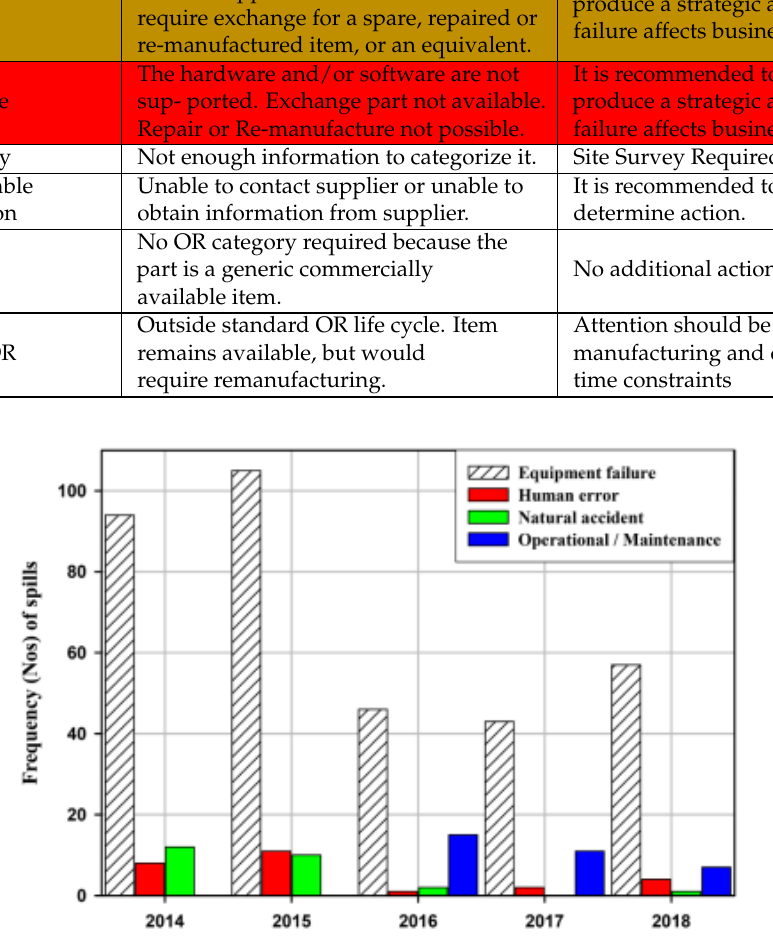
Figure 21. Different factors that were considered for failures of offshore pipelines due to equipment failure, human factor, natural accident, and operation/maintenance. (Image was reused with per-